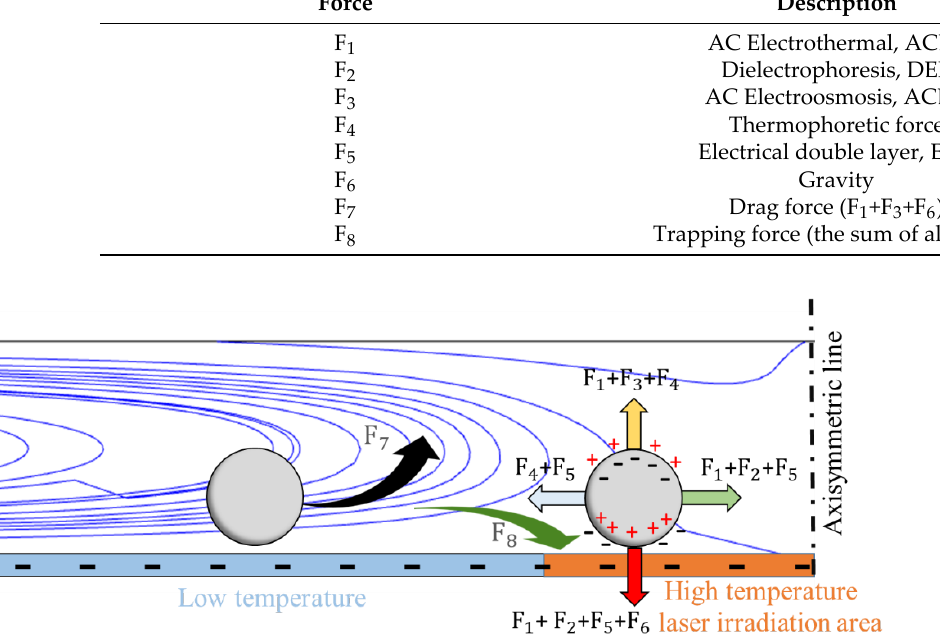
Figure 4. Numerical empirical model used to elucidate relationship among different forces acting in REP chip.